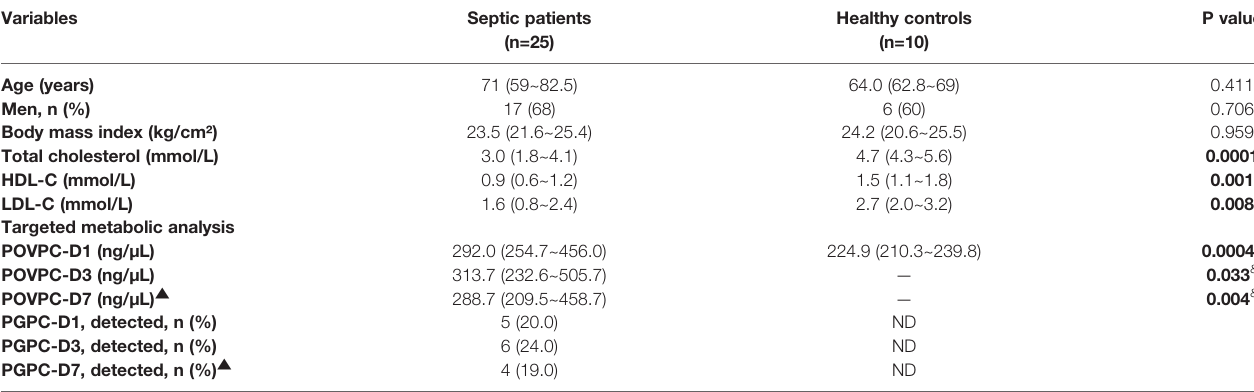
TABLE 1 | Characteristics of septic patients and healthy